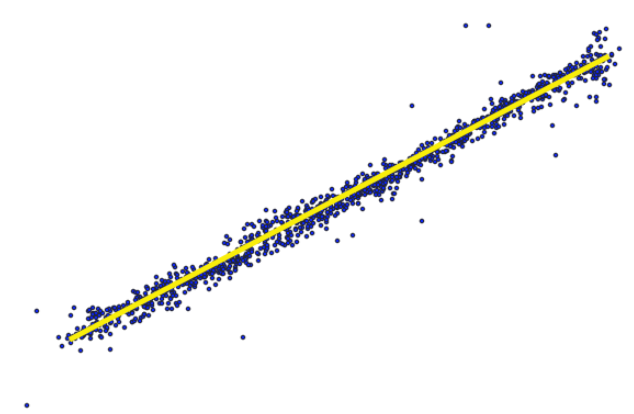
Figure 8. Points from the RTK measurement ( dark blue ) and the fitted reference line ( yellow ).